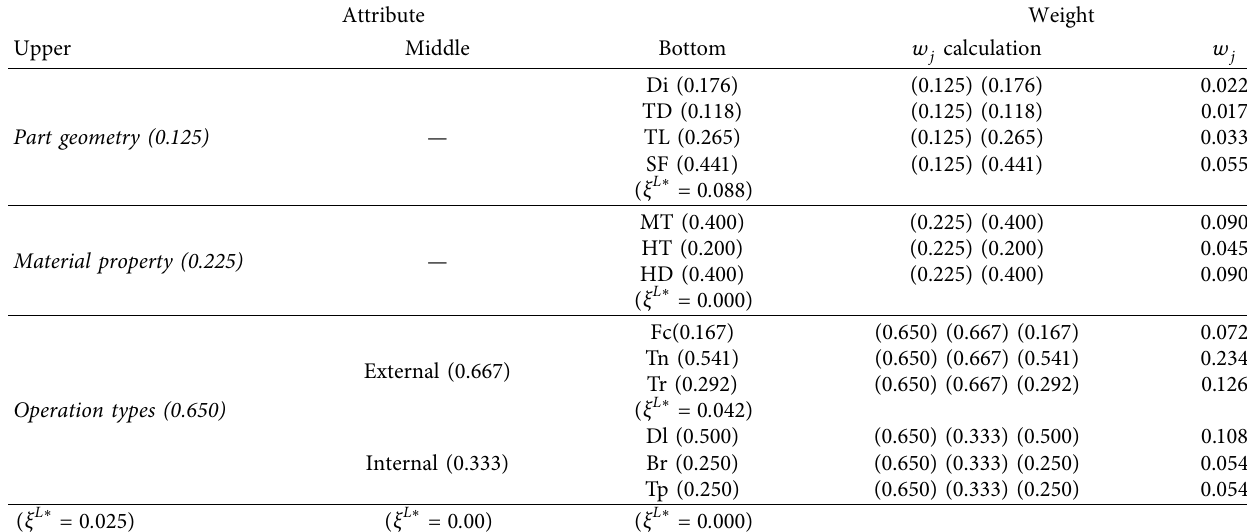
Table 2: Hierarchical BWM based weighting of case attributes.